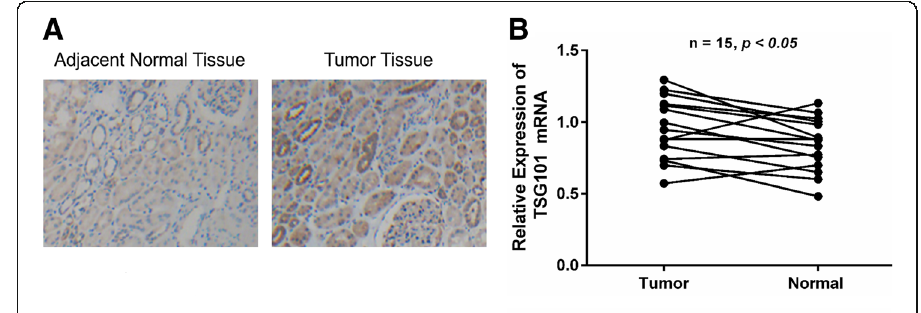
Fig. 1 a Representative immunohistochemistry of TSG101 in tumor tissues compared to adjacent normal tissue of RCC patients (magnification × 100). b The expression of TSG101 mRNA was determined in tumor tissues and their matched adjacent normal tissues by